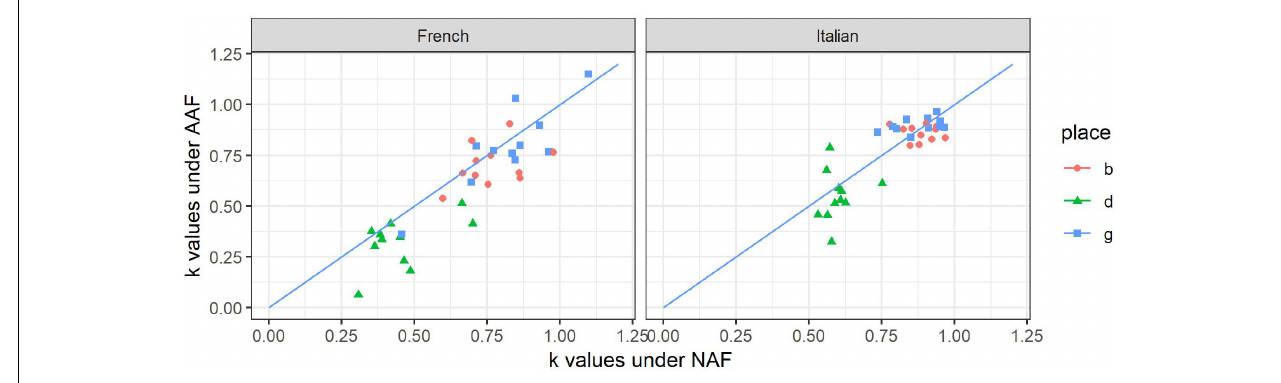
FIGURE 4 | Value of k according to the consonants (b, d, g), and groups (PWNS / PWS) for French and Italian subjects under NAF ( x -axis) and AAF ( y -axis)